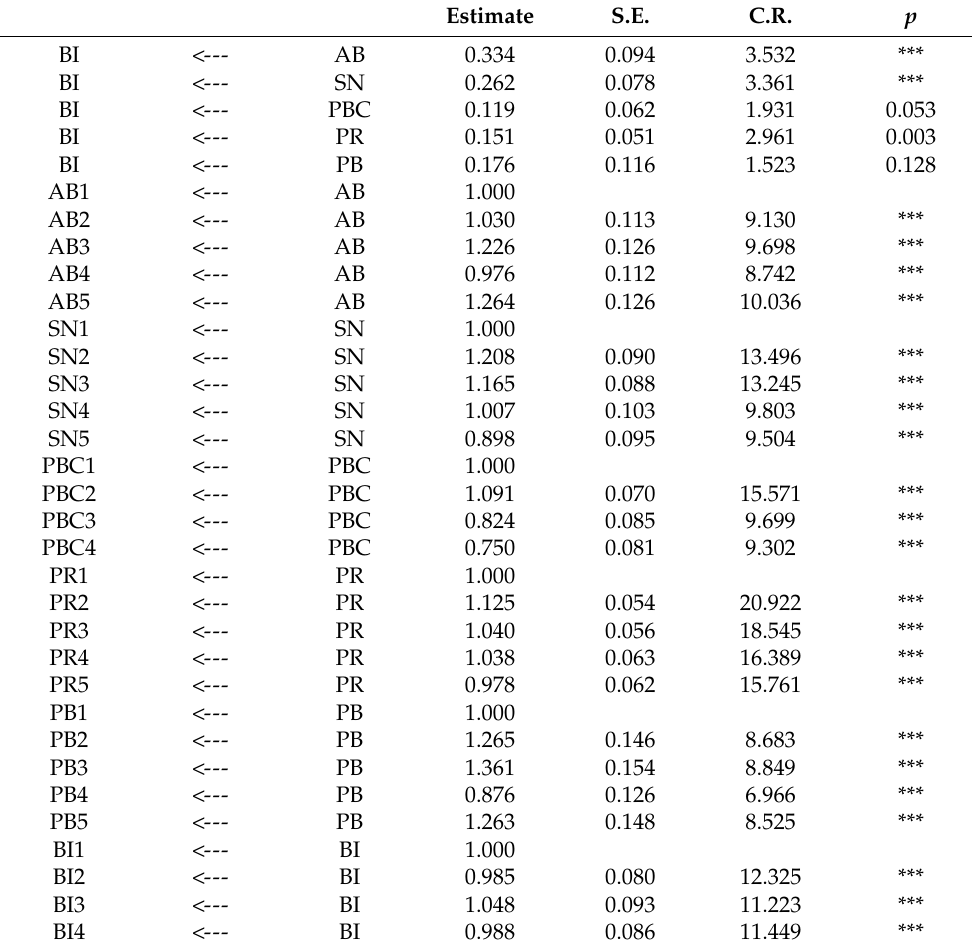
Table 5. Regression weights in the initial model.